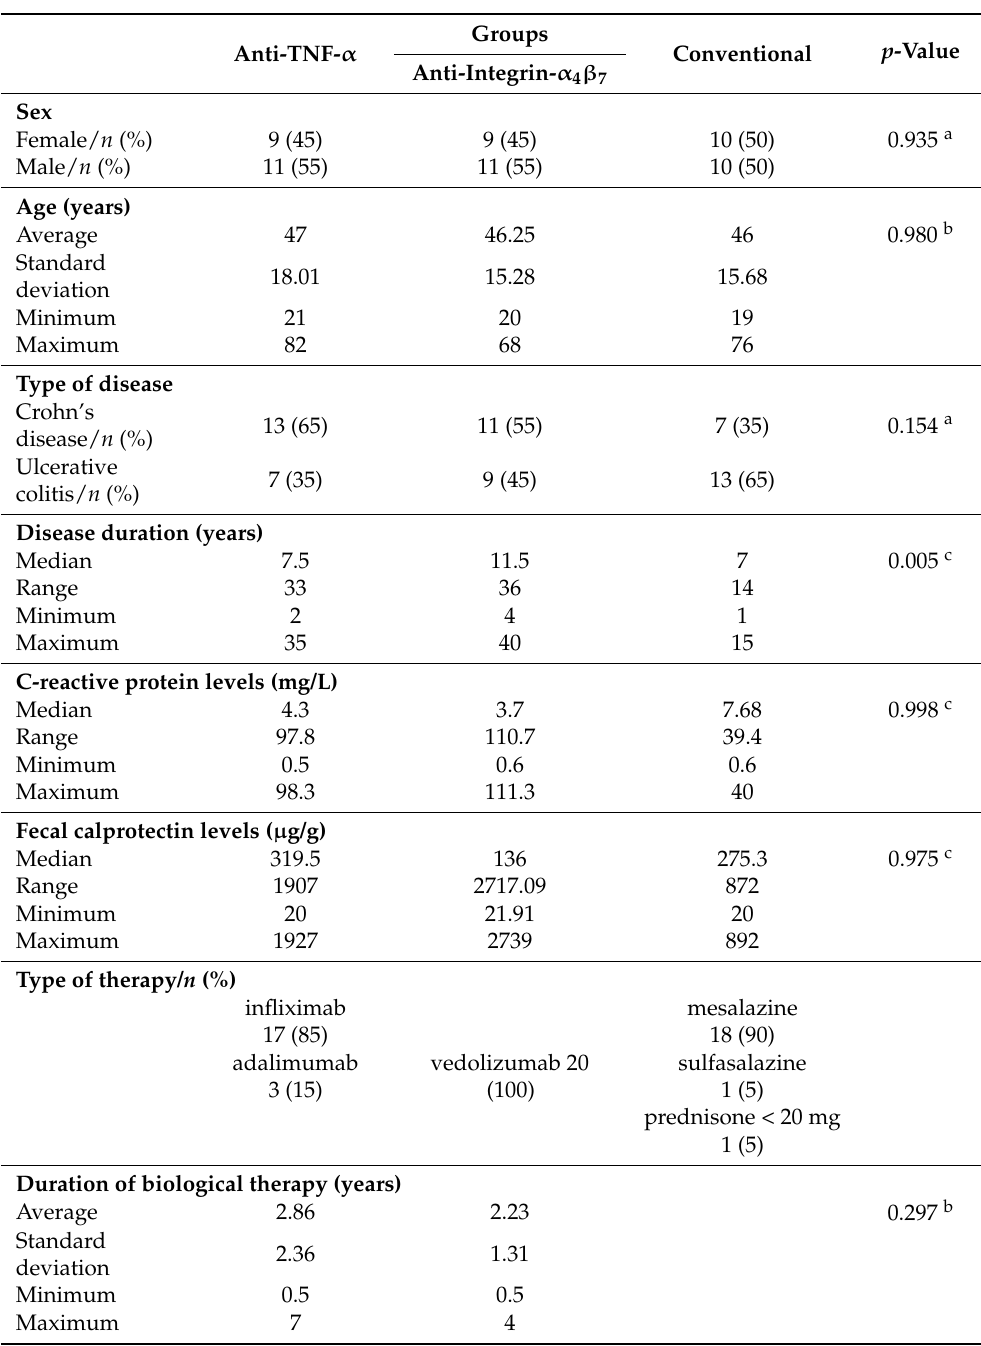
Table 1. Demographic and disease data of the participants in the anti-TNF- α , anti-integrin- α 4 β 7 and conventional groups. Groups Anti-TNF- α Conventional p -Value Anti-Integrin- α 4 β